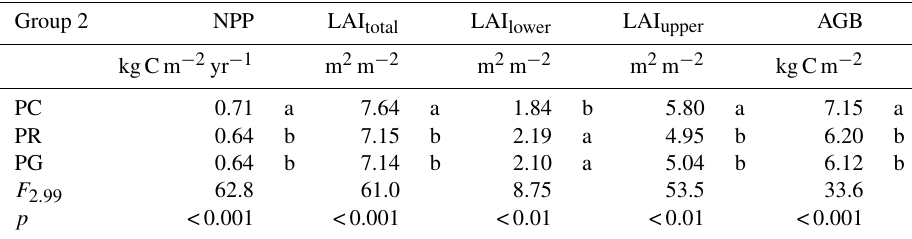
Table 4. Summary of average NPP, LAI and AGB for the Amazon–Cerrado transition zone over the transect domains, considering all P- limitation treatments, regardless of climate and fire presence. One-way ANOVA results are also shown, including F statistics and p values. Values within each column followed by a different letter differ significantly ( p <0.05) according to the Tukey–Kramer test ( n = 1240: 31 pixels × 10 years × n simulation